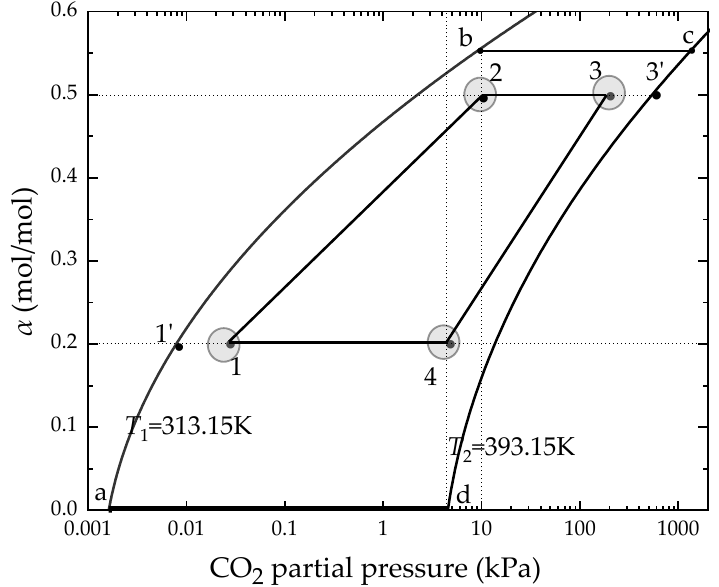
Figure 4. The state points of thermodynamic cycle construction in MEA solution.